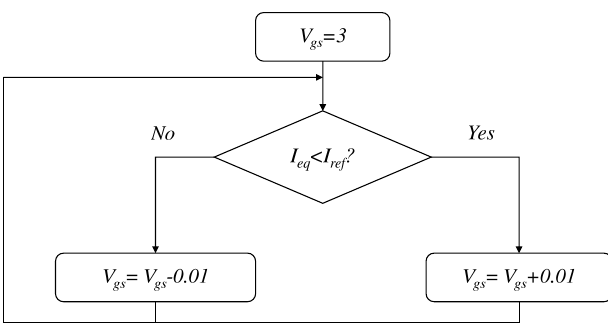
Figure 7. Algorithm for the operation of the shunt switch equalizer.